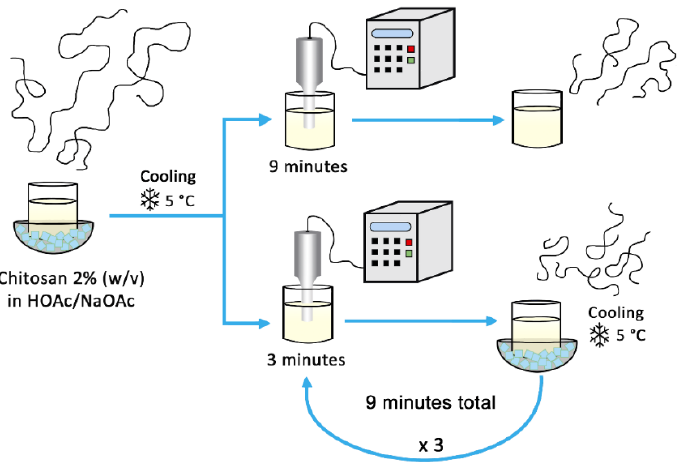
Figure 2. MW reduction with ultrasound.